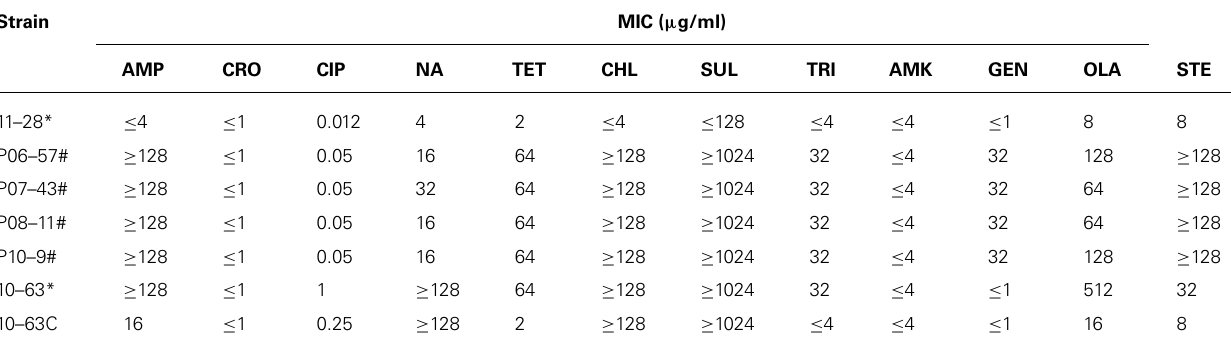
Table 2 | MIC profiles for Salmonella strains with various oqxAB and aac(6 (cid:2) )Ib-cr -borne plasmids.